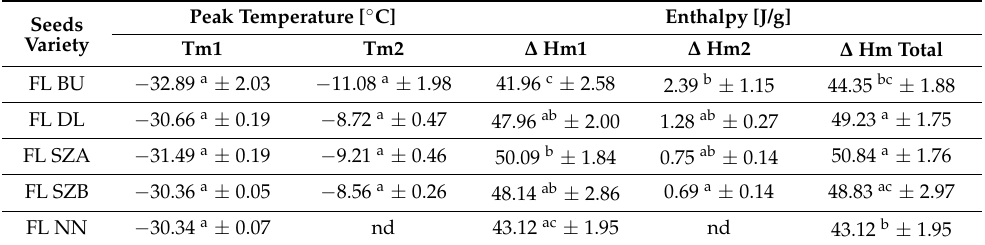
Table 5. DSC thermodynamic parameters of melting process of different cultivars of cold-pressed flaxseed oils obtained by a scanning rate of 2 ◦